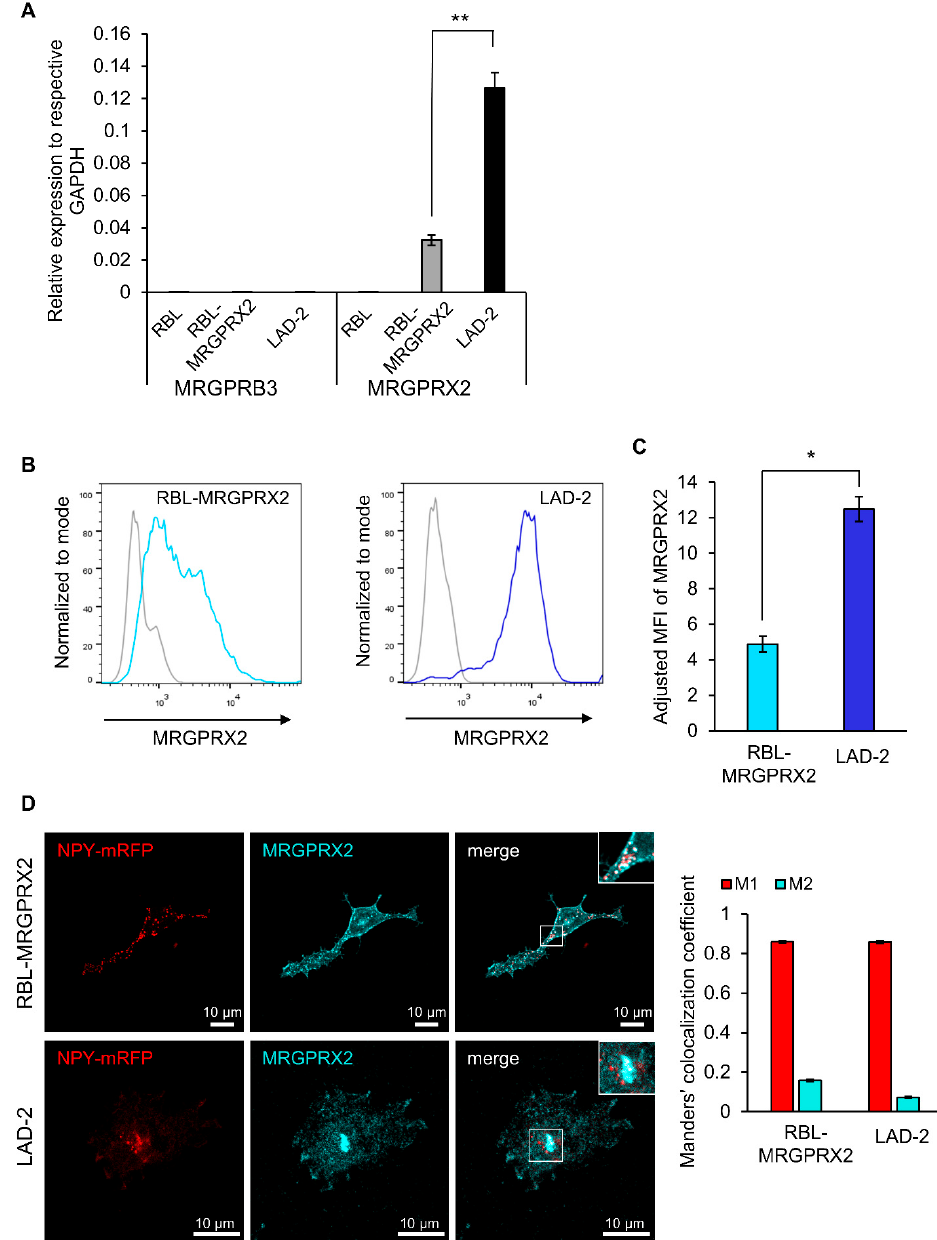
Figure 1. RBL-MRGPRX2 and LAD-2 cells express MRGPRX2 protein and mRNA. ( A ) Expression of human MRGPRX2 and rat MRGPRB3, relative to human and rat GAPDH, respectively, in RBL-MRGPRX2 and LAD-2 cells, was determined by quantitative qPCR. Data are the means ± SEM (n = 4). Statistical significance was determined by Student’s t-test (** p = 0.00619893). ( B ) RBL-MRGPRX2 and LAD-2 cells were directly stained with anti-human MRGPRX2 and analyzed by flow cytometry, for their cell surface expression of MRGPRX2. Gates in histograms (gray, control; blue, RBL-MRGPRX2/LAD- 2) were set according to fluorescence minus one (FMO)-matched control staining. ( C ) The adjusted mean fluorescent intensity (MFI) of MRGPRX2 (MFI of sample/MFI of control). Data are the means ± SEM (n = 3); * p = 0.01290177. ( D ) RBL-MRGPRX2 and LAD-2 cells transiently transfected with NPY-mRFP cDNA were fixed and immunostained using a monoclonal antibody against MRGPRX2 (Biolegend, 1:100), followed by secondary AlexaFluor 647 conjugated goat anti-mouse IgG (H + L) (abcam, 1:500). Cells were analyzed by confocal microscopy. Bars = 10 µ m. Insets are enlargements of the boxed areas. Co-localization of NPY-mRFP with immunostained MRGPRX2 was quantified for 69 LAD-2 and 91 RBL-MRGPRX2 cells from three independent experiments, using the JACoP plugin of the extended ImageJ version Fiji. Error bars represent SEM. The Manders’ co-localization coefficient analysis was employed to measure the extent of overlap of NPY-mRFP with MRGPRX2 in both cell types (Manders’ M1 NPY-mRFP = 0.8586 and 0.8571, and Manders’ M2 MRGPRX2 = 0.1586 and 0.0724, in RBL-MRGPRX2 and LAD-2 cells,